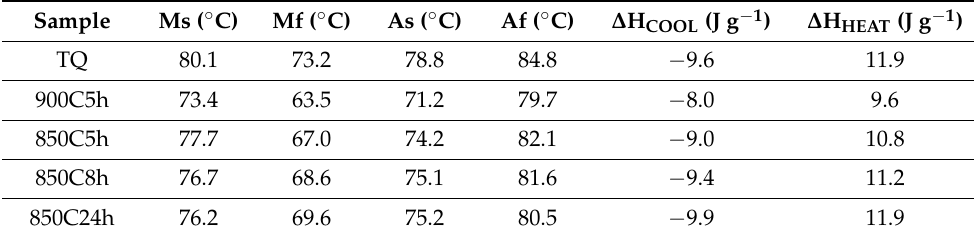
Table 2. Martensite start (Ms) and finish (Mf) temperatures, austenite start (As) and finish (Af) temperatures, and transformation enthalpies during cooling and heating stages obtained from DSC analysis of NiTiCu samples.